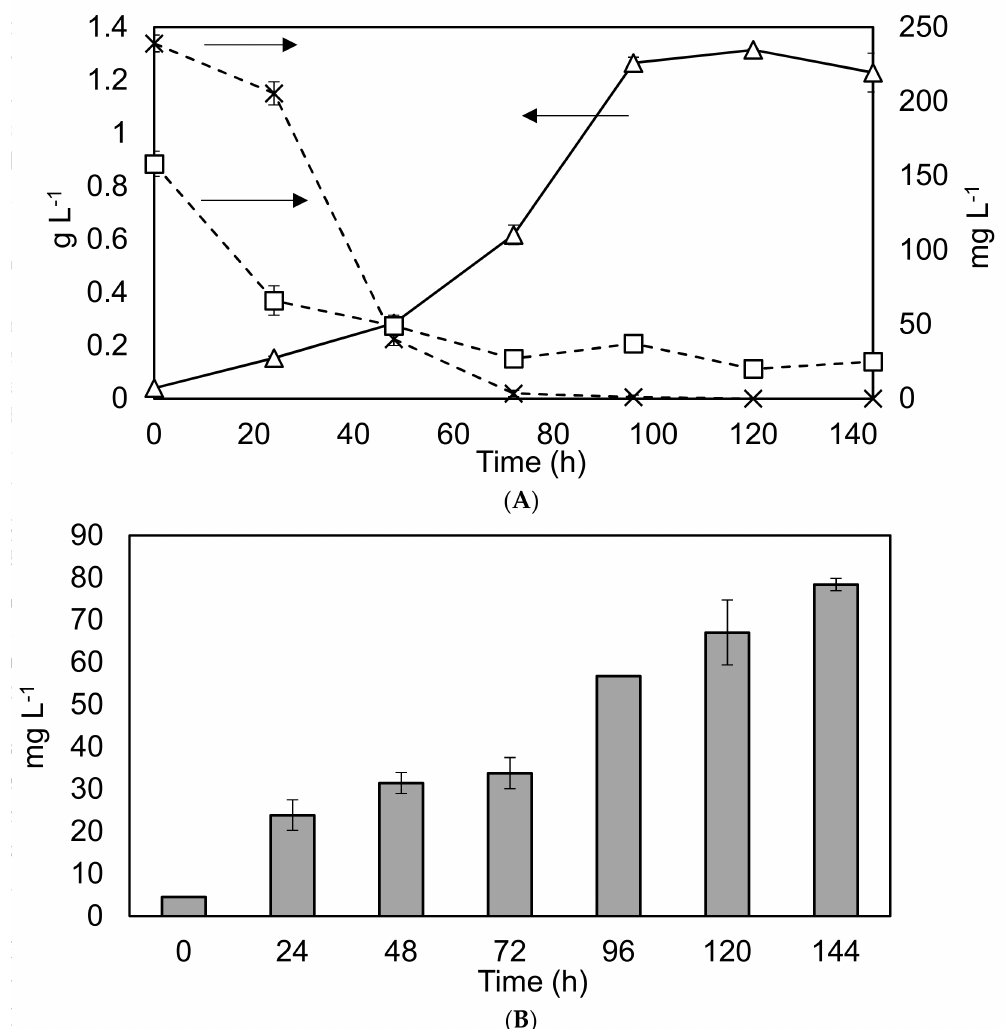
Figure 4. Nutrient removal and lipid production profiles in the 1 L Duran bottle reactor under different conditions. Graph ( A ) Solid black line with triangles represents biomass dry weight on the primary y-axis, while the dashed lines represent nutrient depletion on the secondary y-axis. Squares: phosphate levels. Crosses: nitrate levels. Experiments were undertaken in triplicate, and the error bars show one standard deviation from the mean, arrows clarify the axis to which the data corresponds. Graph ( B ) Grey bars show the lipid concentration. Triplicate experiments, error bars show 2 standard